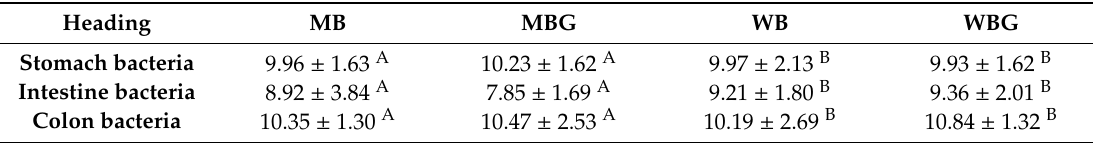
Table 2. Bacterial load (logarithms) from the stomach, intestine, and